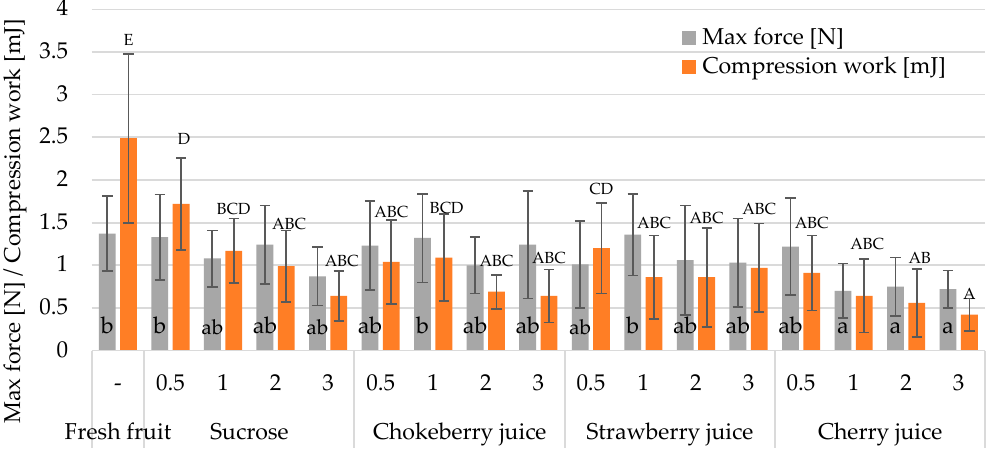
Figure 3. Effect of the type of osmotic agent (sucrose and fruit concentrates) on the mechanical properties of osmodehydrated strawberries. Different letters (small letters are for max force, capital letters are for compression work) above columns show the statistical difference ( p < 0.05).